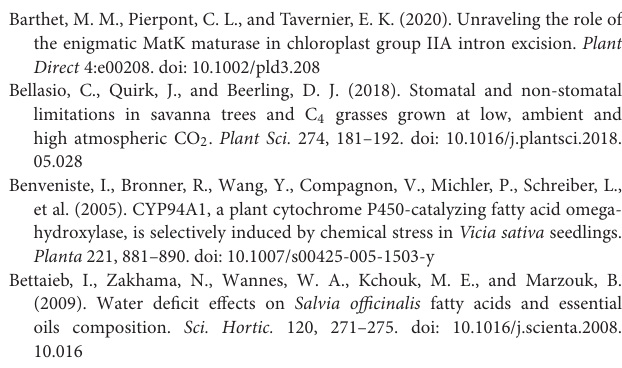
Supplementary Figure 1 | Confocal laser scanning micrograph of chloroplasts in the bundle sheath cells from the paraffin section of three different ecotypes of reed. The chlorophyll fluorescence was illuminated with 488nm (red images) and 561nm (green images) light wavelength separately, the third column (yellow images) were their merged ones (bars = 30 µ m). (A–C) Swamp reed (SR); (D–F) heavy salt meadow reed (HSMR); (G–I) dune reed (DR). BSC, bundle sheath cell; CP, chloroplast. Supplementary Table 1 | The detailed information of interaction network of the differentially accumulated proteins generated by STRING